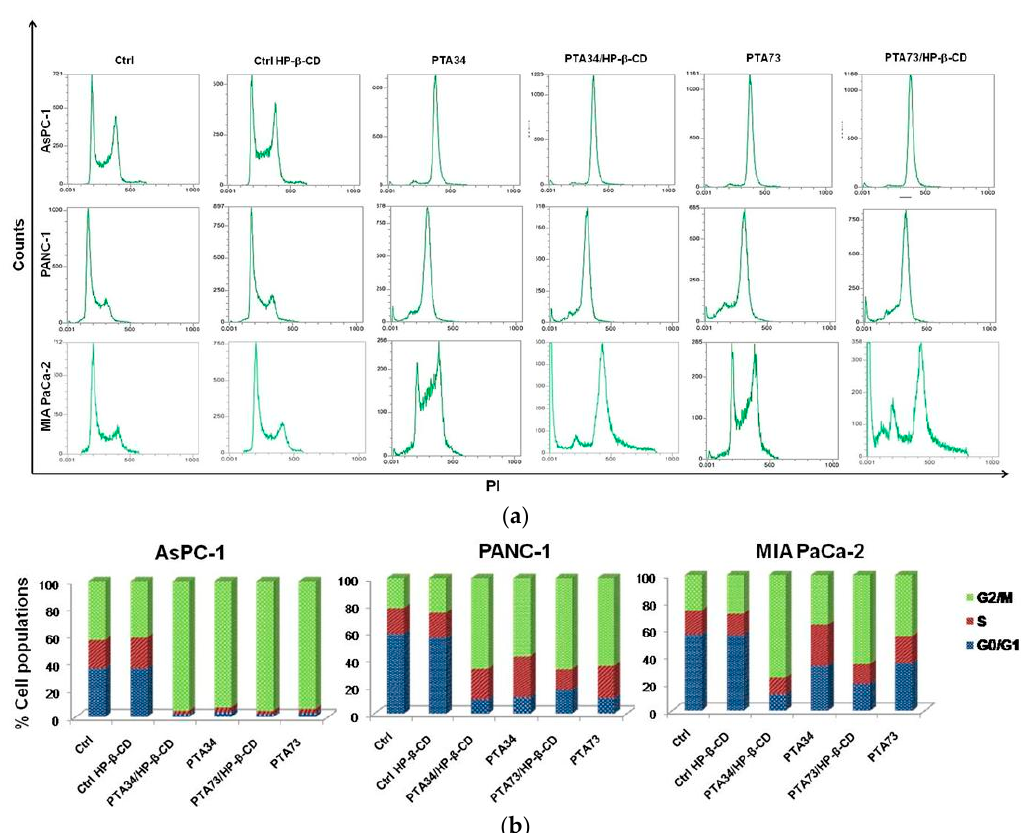
Figure 6. Effects on cell cycle of PDAC cells by CD (Ctrl-CD), complexed PTA34 and PTA73 (PTA34/HP- β -CD and PTA73/HP- β -CD, respectively) and PTA34 and PTA73, alone. The modulation of cell cycle phases was evaluated by flow cytometry (FCM) analysis after staining cells with propidium iodide. In panel ( a ), a representative analysis of three independent experiments is reported for all cell lines investigated. In panel ( b ) the bar graph shows cell population percentage in each phase of the cell cycle.